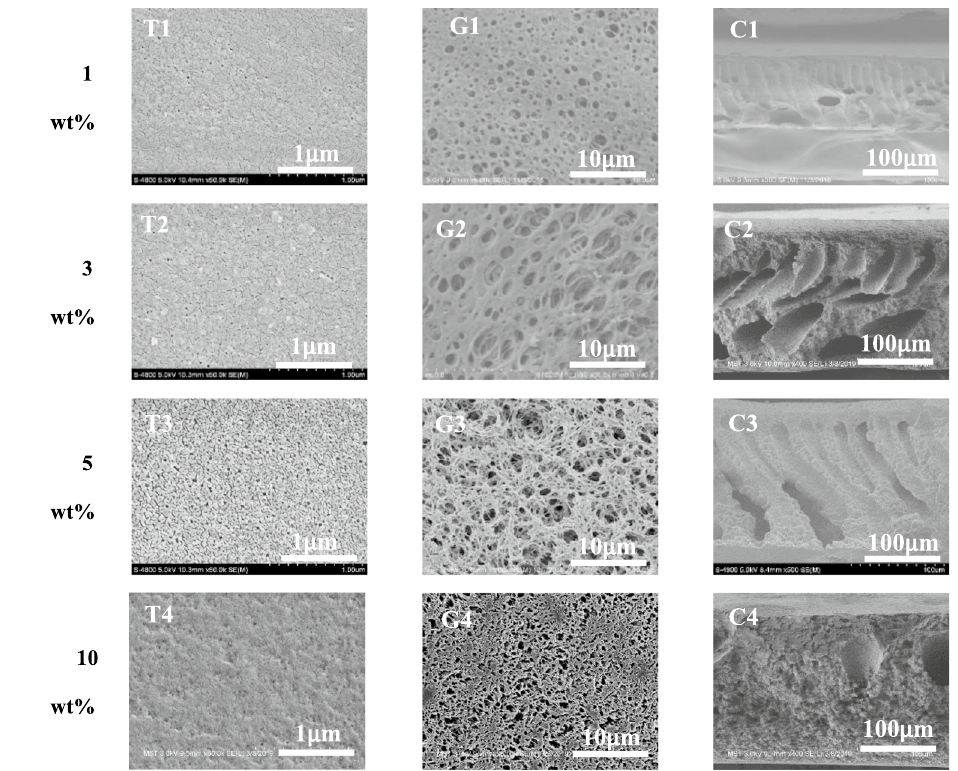
Fig. 6 SEM images of PVDF membranes prepared with different PVP concentrations (T, G, C represent top surface, glass side and cross section, respectively)